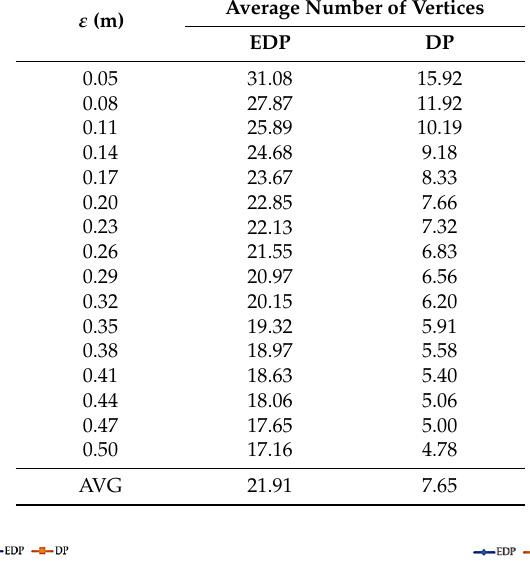
Table 2. Average number of vertices created by EDP and DP (The numbers of obstacles and vertices of each obstacle were fixed as 15, and θ rot for EDP was fixed as 30 ◦ ).